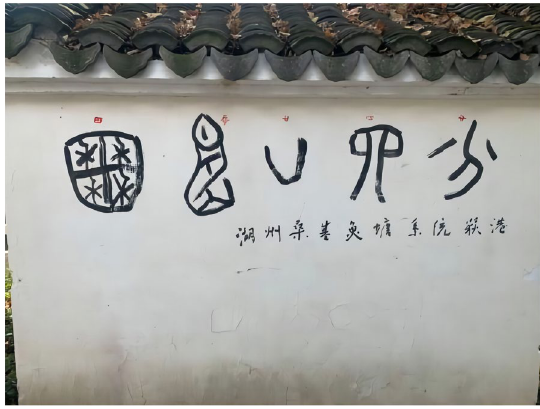
Fig. 6 The internal structure of the transformed building (Source: the